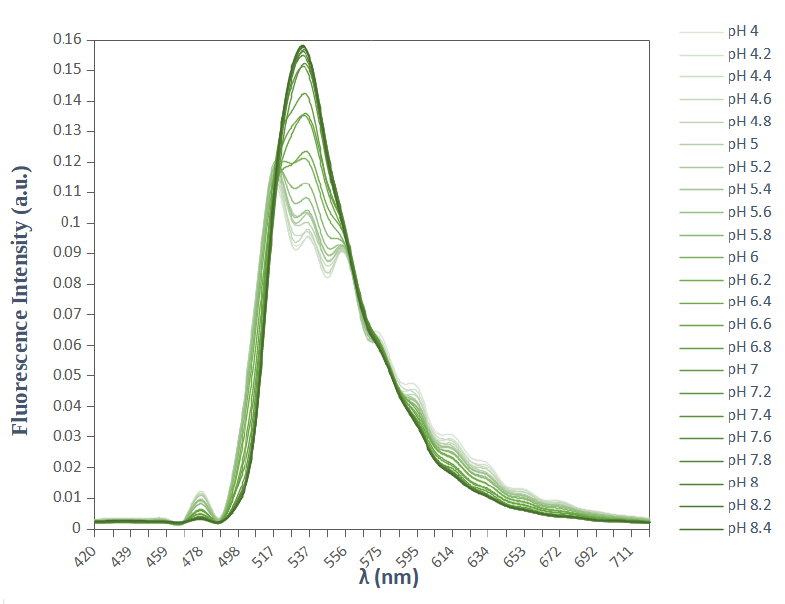
Figure 2. Emission spectra of BCECF in DMEM serum-free medium at various pH values. BCECF exhibits a single emission peak at 537 nm. Excitation wavelength is 488